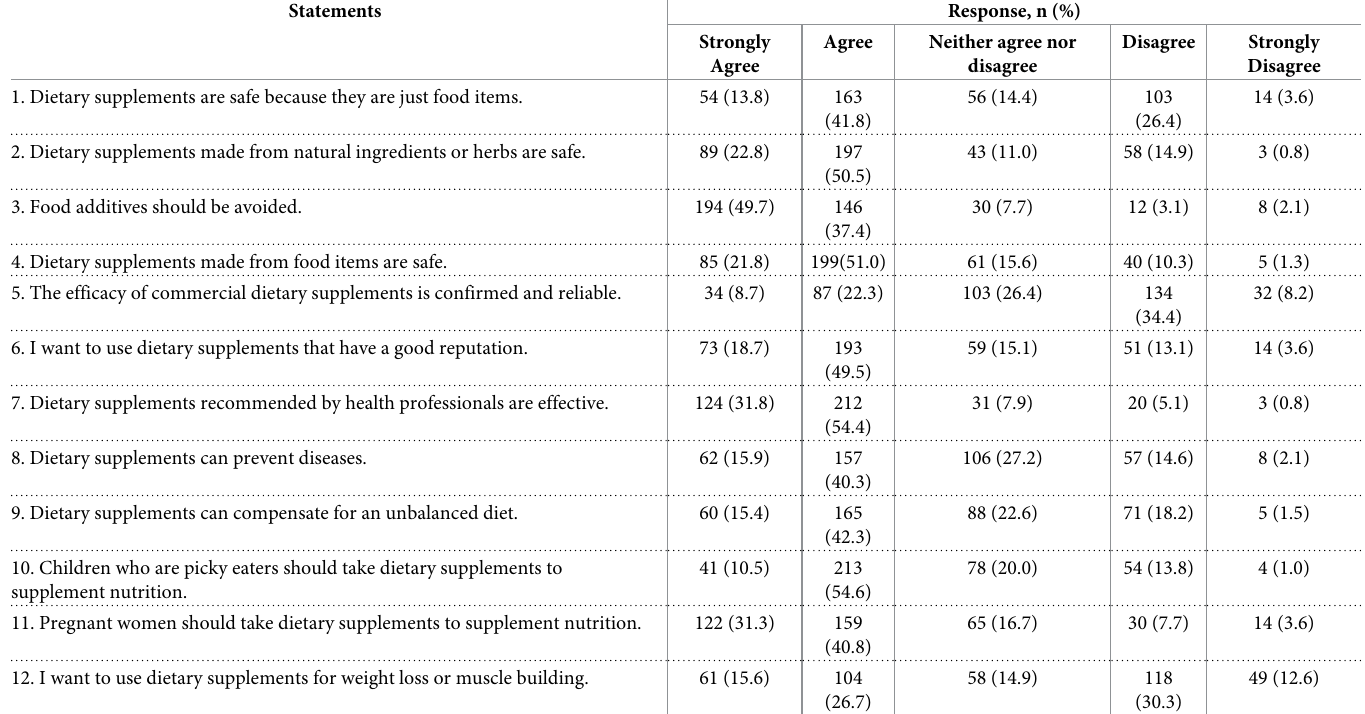
Table 2. Knowledge about dietary supplements among university students (N = 390).